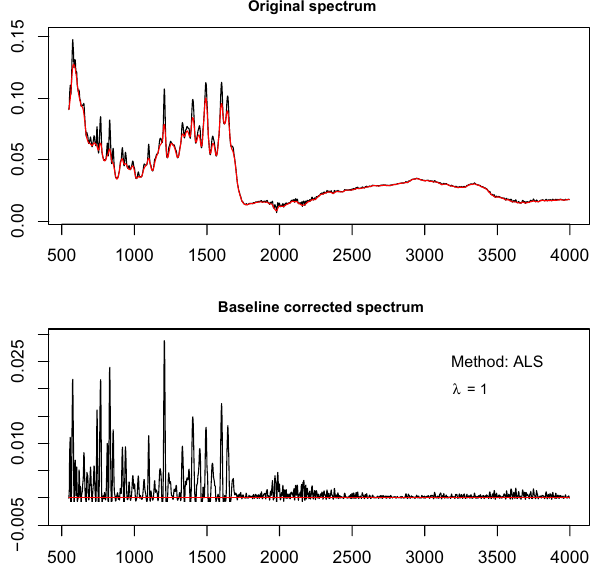
Figure 2. The comparison of original and baseline corrected spectral data is shown here. The base line is corrected using ALS with smoothing parameters (lambda = 1) and weights (w =